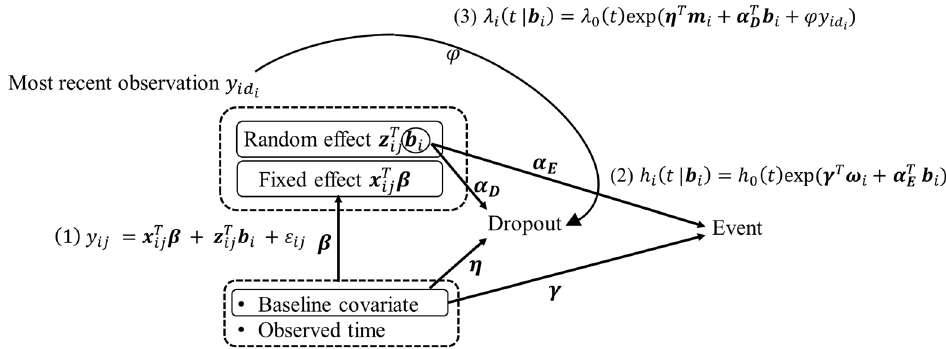
Figure 1. Causal diagram for the proposed model that contains the three submodels.